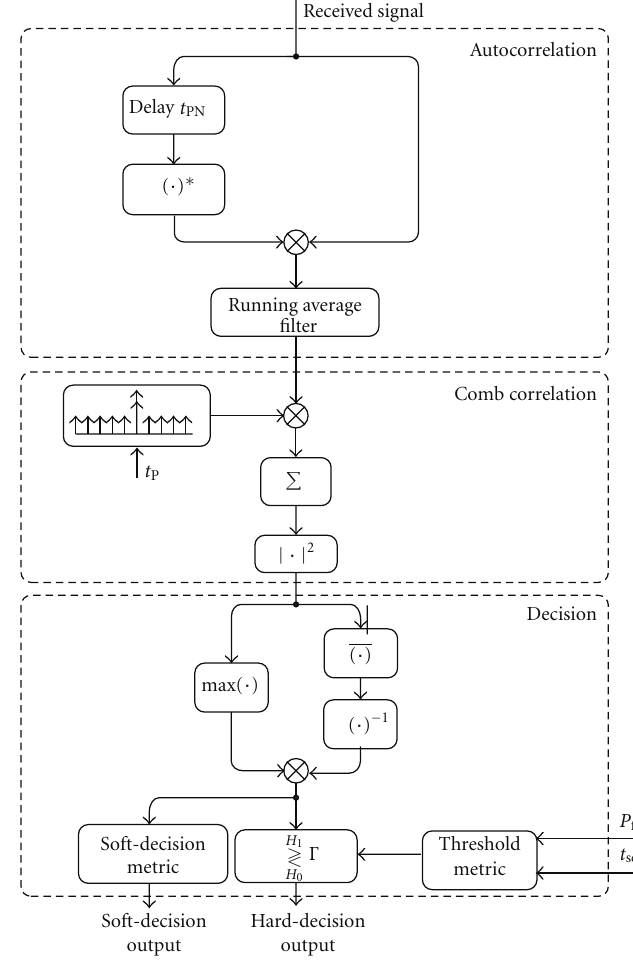
Figure 6: Flow diagram of the DTMB sensing